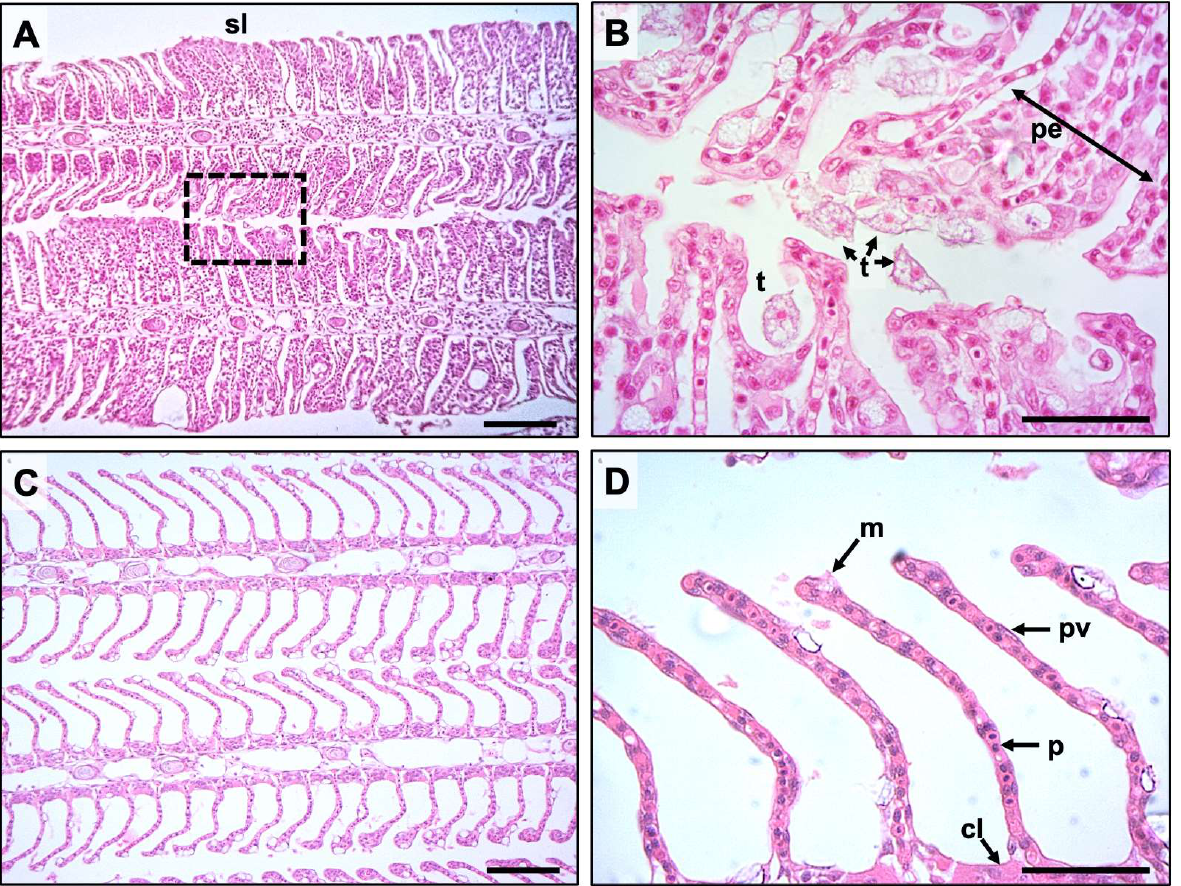
Figure 3. Representative histological sections of gill obtained from the experiment; ( A ) Gill lesion along both margins of primary lamellae, showing extensive fusion of secondary lamellae (sl), scale bar = 50 µ m. ( B ) shows border inset from ( A ) at 400 × magnification, demonstrating N. perurans trophozoites with clearly discernable nuclei (t) attached and adjacent to areas of proliferating epithelium (pe) scale bar = 100 µ m. ( C ) negative control group, depicting anatomically normal gill morphology, scale bar = 50 µ m. ( D ) Higher magnification of normal healthy gill (400 × ) showing typical cell types including mucus (m), pavement (pv), pillar (p) and chloride (cl) cells, scale bar = 100 µ